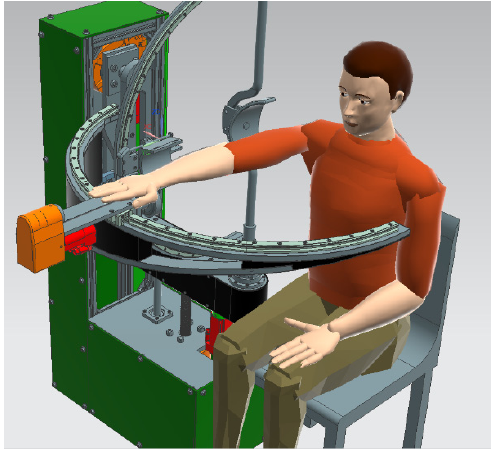
Figure 4. Virtual setup for simulation.